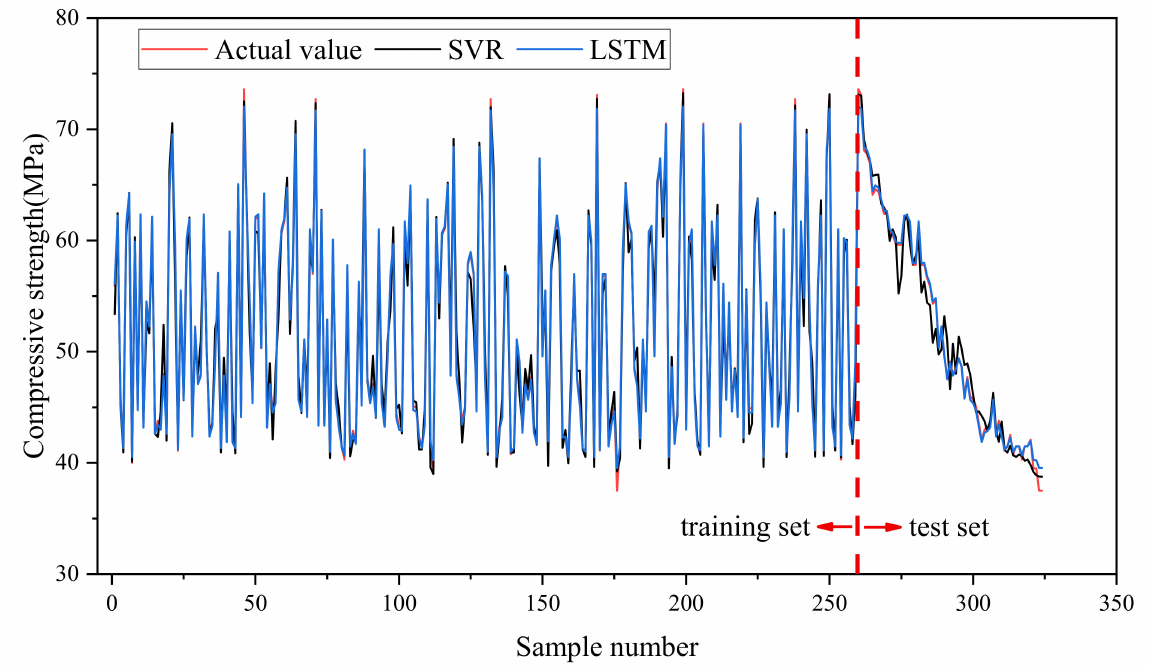
Figure 5. The prediction performance of the LSTM and SVR